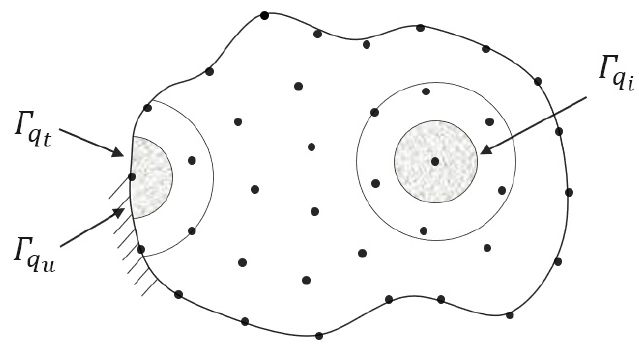
Figure 1. Local domains and boundaries of MLPG.